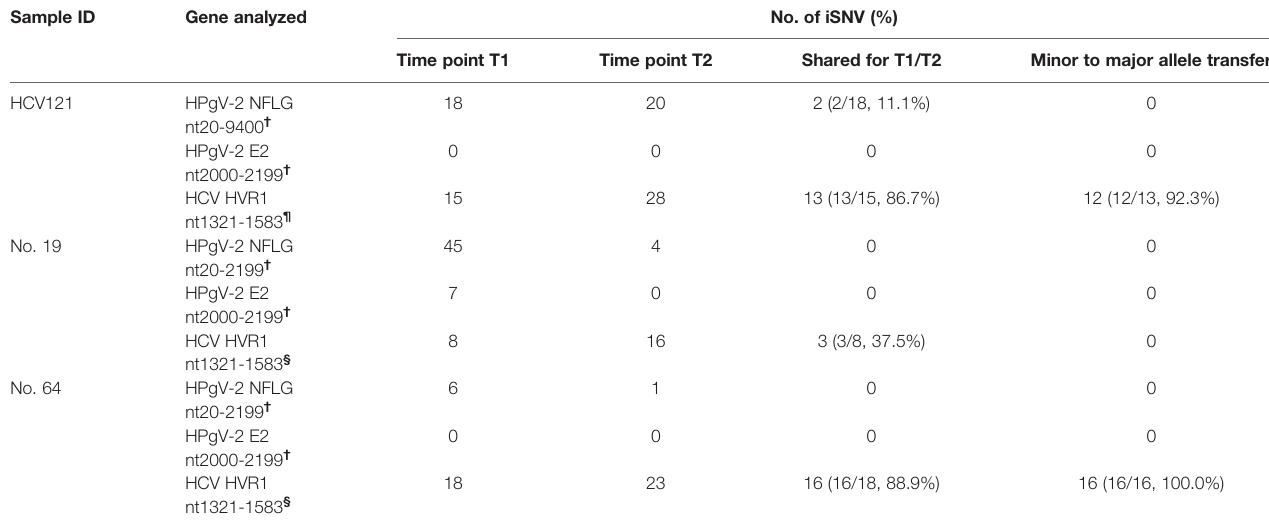
TABLE 4 | Shared intrahost single nucleotide variations between the longitudinal samples of HCV/HPgV-2-coinfected patients. Sample ID Gene